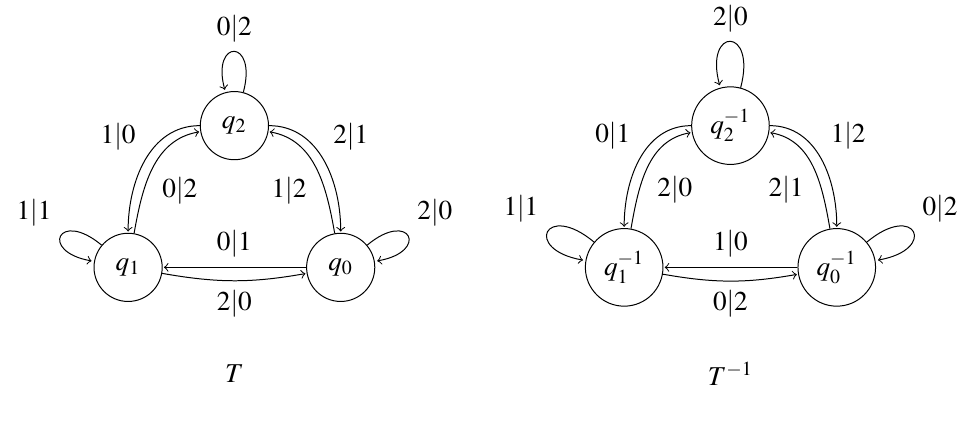
Figure 2: Inverting a synchronous transducer T